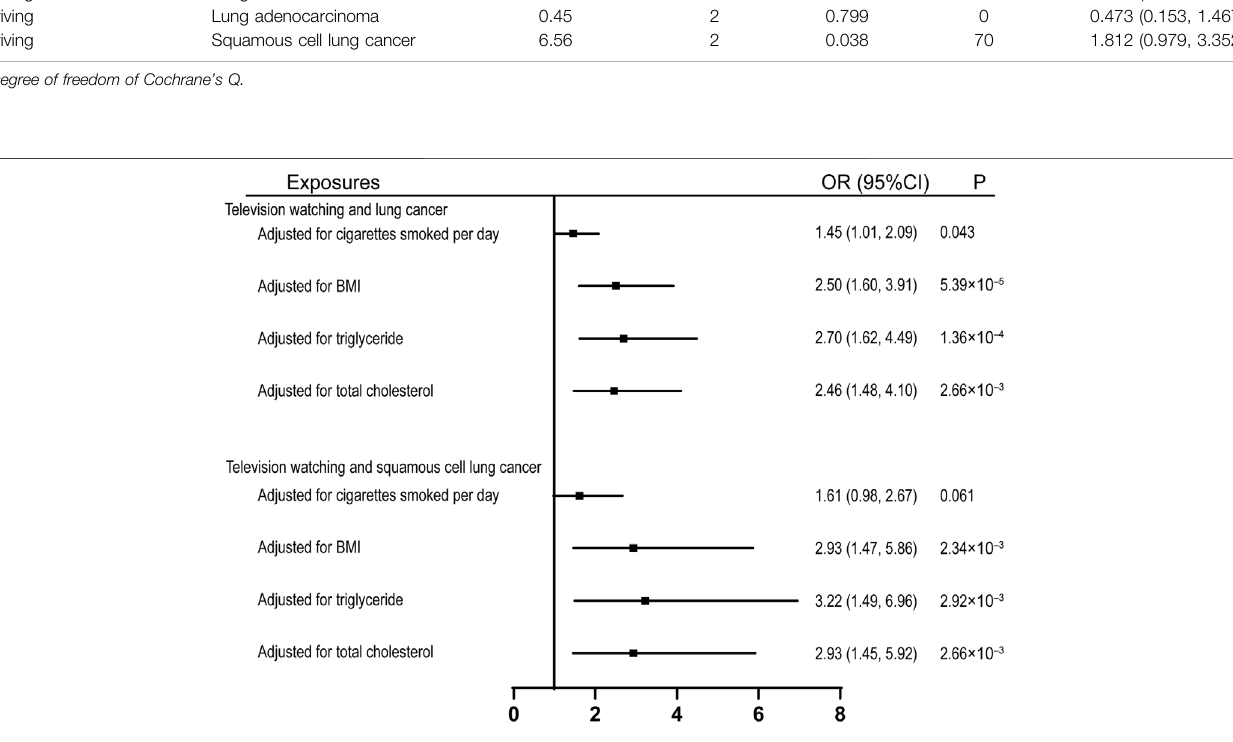
Frontiers in Genetics |